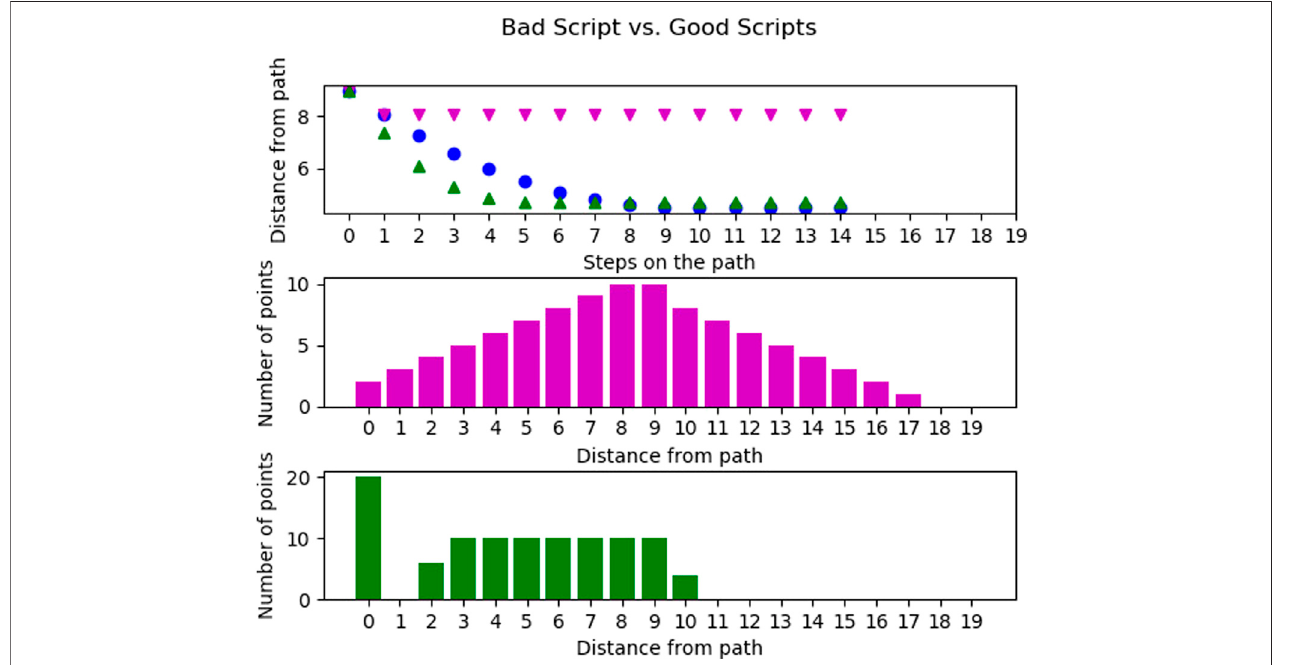
FIGURE 6| Comparison of the single action trajectory ofthe script ( west, east, west, east ) in magenta( ▼ ) and the script ( west, north, east, north ) in green ( ▲ ) from thesoutheastcorneroftheworld.Top,theaveragedistance ( V g ) ofthepossiblegoalstatespersteponthetrajectory.Middle,numberofgoalswithagivendistancefor the script ( west, east, west, east ). Bottom, number of goals with a given distance for the script (west, north, east, north).